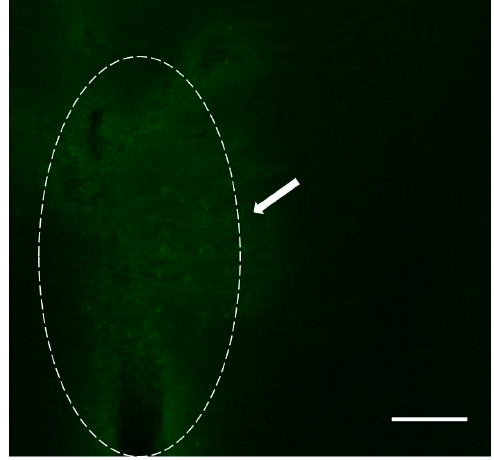
Figure 8. Confocal image of G4-90/10 dendrimer surrounding the needle tract (arrow pointing to the region). Image was taken at 40× magnification using Olympus BX50 Upright Microscope (Olympus, Shinjuku, Tokyo, Japan). Scale bar: 100 μ m.